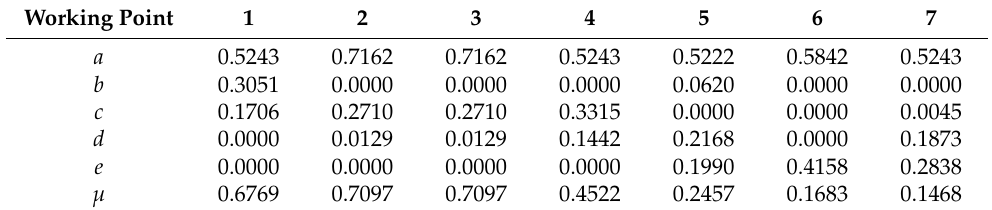
Table 6. Five-element Connection Degree of Comprehensive Evaluation of Each Working Point.